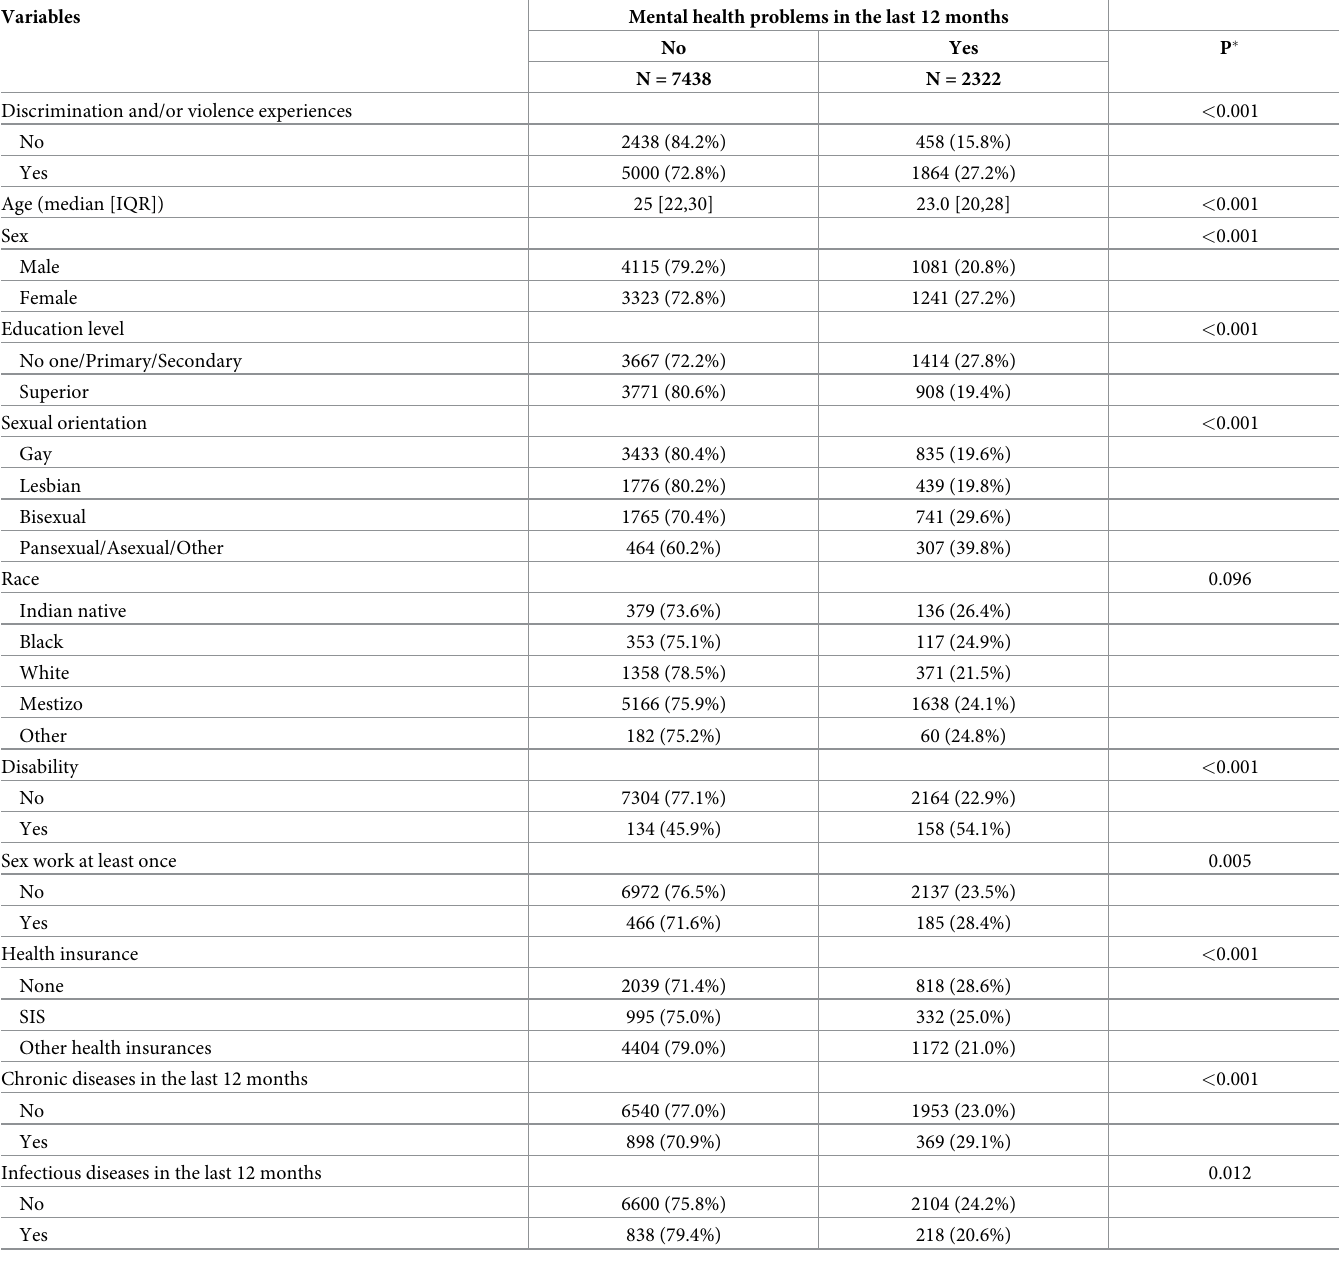
Table 2. Mental health problems in the last 12 months by characteristics of the Peruvian sexual minority aged 18 to 60 years old (n = 9760).